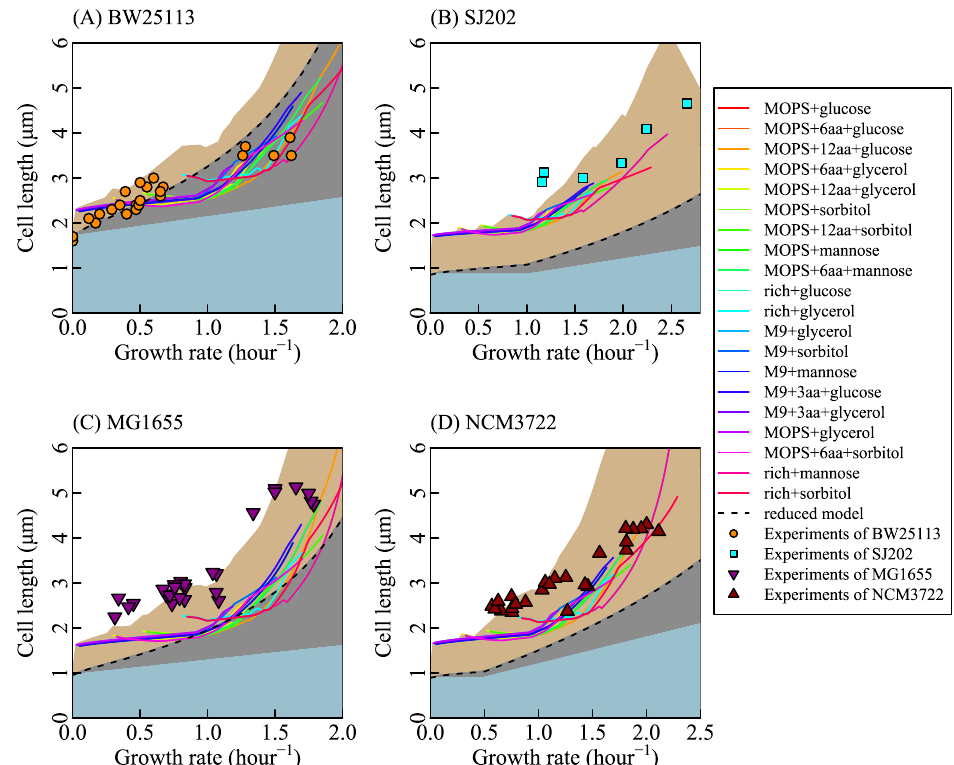
Figure 2. Comparison between the results of size estimation based on flux balance analysis (SEFBA) with experimental data. The solid lines in different colors are the results of SEFBA. Each color of the solid lines stands for a kind of culture medium which is determined by reactions bounds. K M is 2 × 10 − 35 ( mol/ µ m 2 ) 2 , and β is 0.5 in all sub-figures. The dashed lines were drawn by Equation (31), where parameter C is 2.96 and parameter H is 1. Cell width D changes linearly with the growth rate based on experiments data [6,9,13]. The parameter E is 0.04 in ( A ), 0.023 in ( B ), 0.04 in ( C ), and 0.035 in ( D ), standing for the variation rate of cardiolipin synthesis with growth rate. The upper edges of light blue area were calculated by setting w CLPNS zero while changing cell width D , so the light blue area represents the cell length variation caused by cell width. The upper edges of light gray area were calculated by setting w CLPNS a positive value while changing cell width D , so the light gray area represents the cell length variation caused by r CLPNS . The upper edges of brown area were calculated by setting n 0 changing with growth rate (same to cell width changing with growth rate) in SEFBA. ( A ) The circles in orange are the experimental data [13] with the strain of BW25113. n 0 is 1 × 10 − 16 . V max is 0.38 mmol/(gDW · h). ( B ) The squares in cyan are the measured data from experiment [9] with the strain SJ202. n 0 is 5.8 × 10 − 17 . V max is 0.76 mmol/(gDW · h). ( C ) The inverted triangles filled with purple are from experiments of MG1655 [6]. n 0 is 5 × 10 − 17 . V max is 0.3 mmol/(gDW · h). ( D ) The regular triangles filled with red are experiments of NCM3722 [6]. n 0 is 5.3 × 10 − 17 . V max is 0.38 mmol/(gDW · h). The values of V max for BW2513 and MG1655 are based on the mass spectrometric data [69], and the values of V max for SJ202 and NCM3722 were obtained by fitting experimental data. The values of n 0 for each of the bacterial strains were estimated based on the cell width. (cid:101) is 3.4 obtained by fitting the